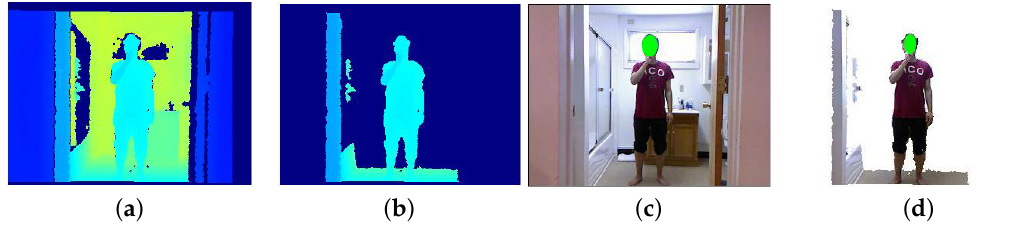
Figure 2. Pre-Processing: ( a ) original depth; ( b ) depth after applying maximally stable extremal regions (MSER); ( c ) original RGB; ( d ) combining image ( c , b